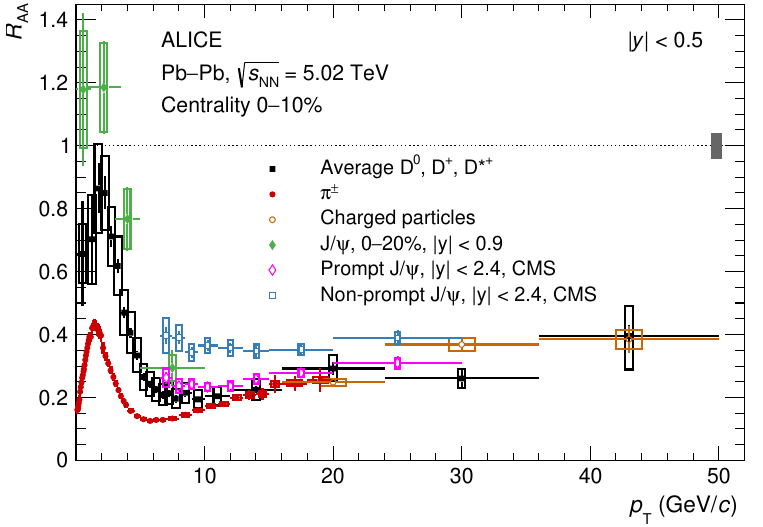
Figure 9 . Average R AA of prompt D 0 , D + , and D ∗ + mesons in the 0–10% centrality class compared to R AA of charged pions [84], charged particles [85], inclusive J/ ψ measured by ALICE [87], and of prompt and non-prompt J/ ψ from CMS [61] in Pb–Pb collisions at